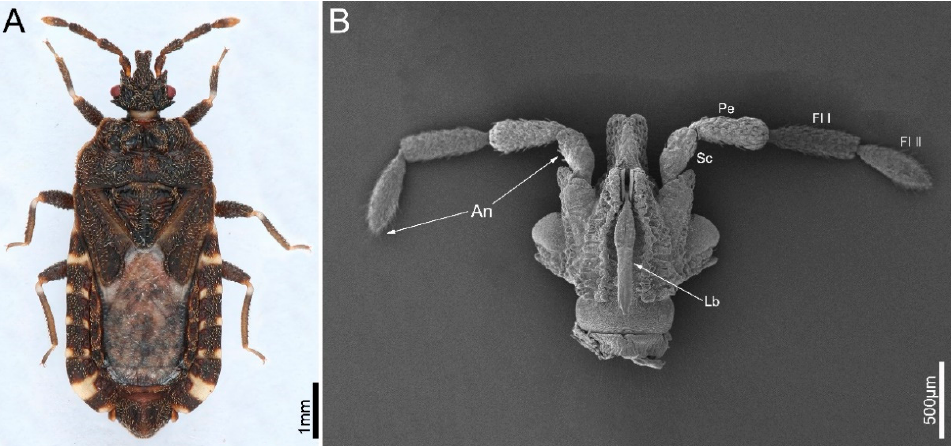
Figure 1. Habitus and general head morphology of Mezira yunnana . ( A ) Dorsal habitus of the male; ( B ) morphology of head with antennae and labium. An: antennae; Fl I-II: flagellum I-II; Lb: labium; Pe: pedicel; Sc: scape.